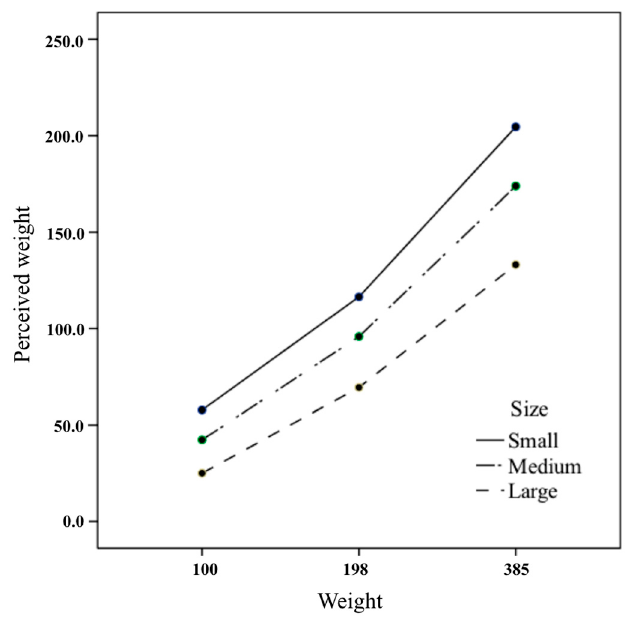
Figure 1. Interaction e ff ects of size and weight of cookie box on perceived weight. Table 4. Perceived weight comparison of the three cookie box